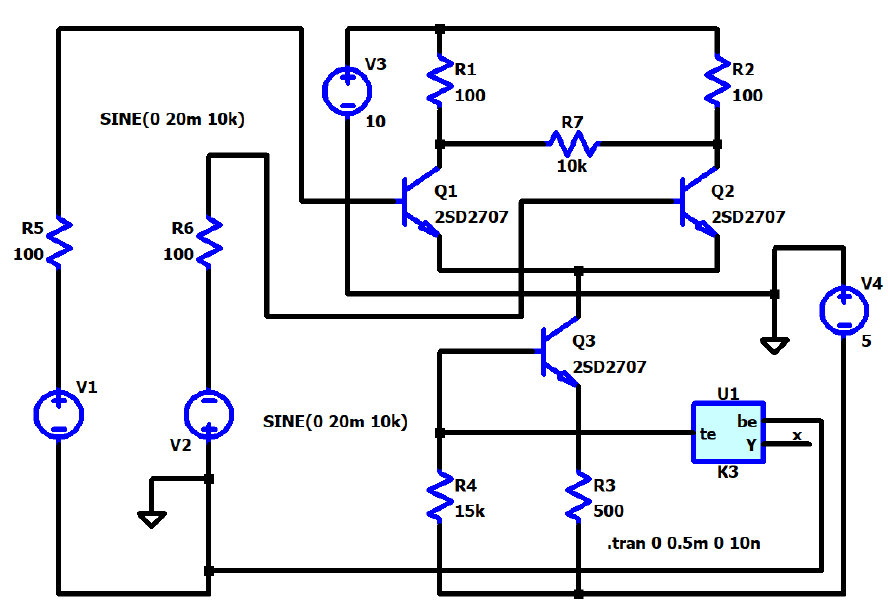
Figure 10. A memristor-based differential amplifier.